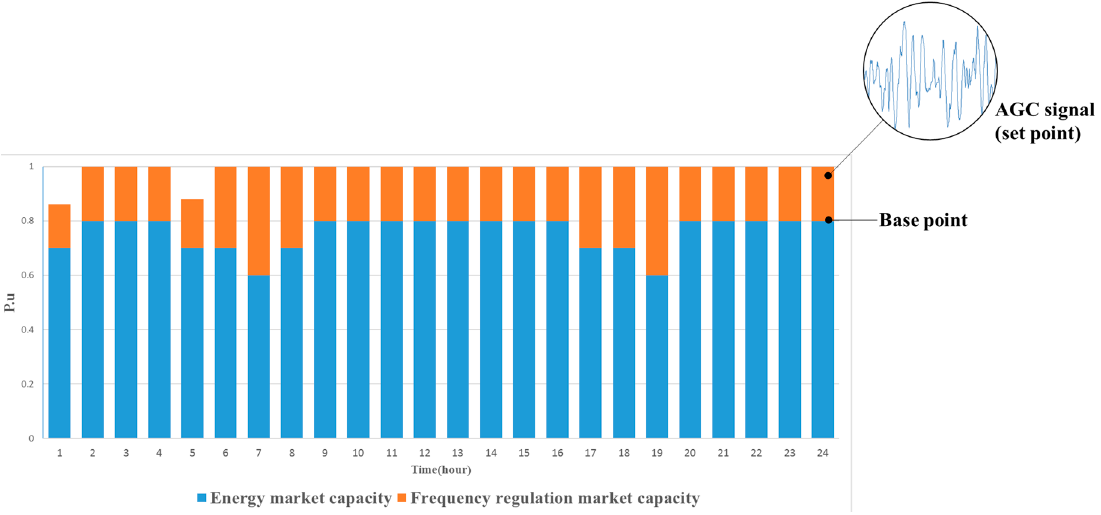
Figure 1. The concept of set point and base point. AGC: automatic generation control.